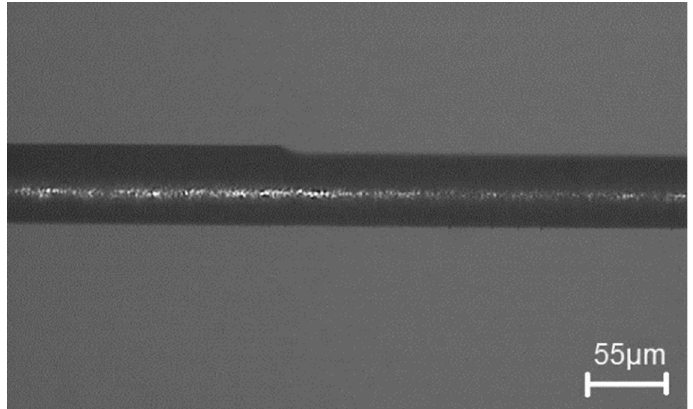
Figure 15. Side view of cut-side shaped micro-tool.